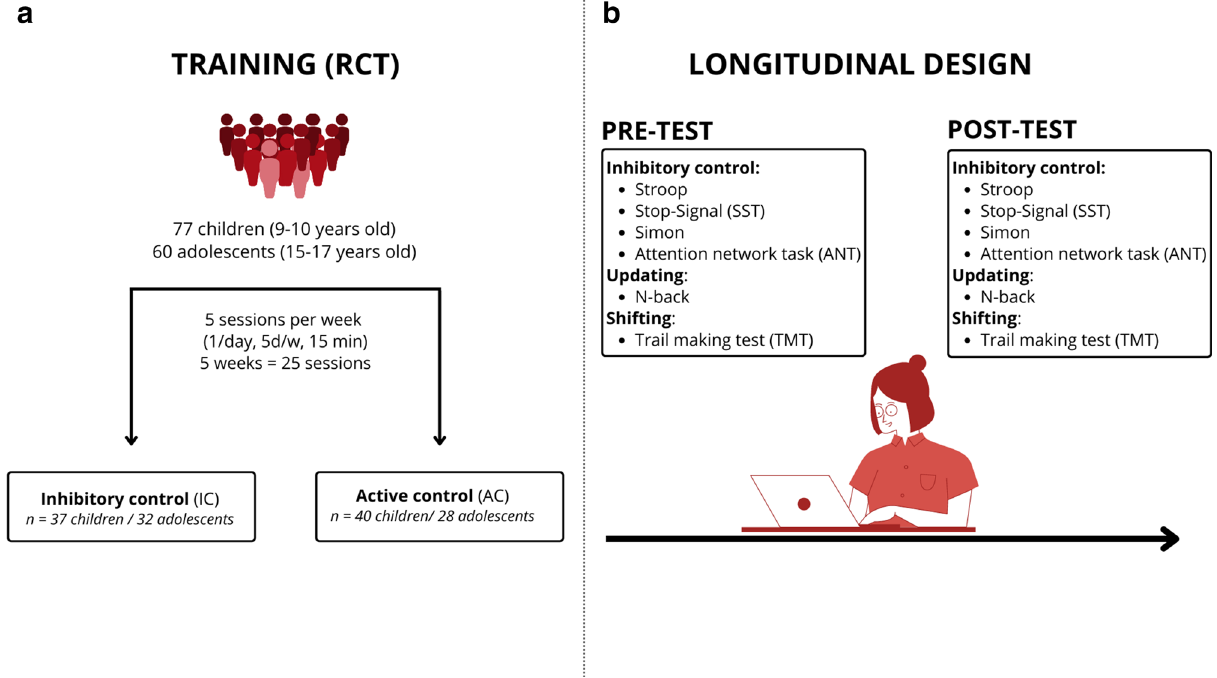
Figure 1. Experiment design. ( a ) 77 children (9–10 y.o.) and 60 adolescents (15–17 y.o.) were asked to perform inhibitory control tasks (IC group) or knowledge- and vocabulary-based tasks (Active Control (AC) group) 15 min per day, 5 days a week for 5 weeks (25 sessions) on a tactile tablet. Participants were randomly assigned to the IC or the AC groups as in a Randomized Controlled Trial (RCT). The AC condition allowed to control for test–retest effects. In both IC and AC training, the difficulty was progressively increased and adapted in real time to the learning curve of each participant to maintain the motivation of the participant and to prevent automaticity. ( b ) Participants performed a cognitive battery in the pre- and post-training sessions (longitudinal design) measuring different facets of executive functions: cognitive flexibility/switching (TMT), working memory updating (N-back task), and inhibitory control (Stroop task for interference control, Stop Signal and Simon tasks for response inhibition and ANT for attentional